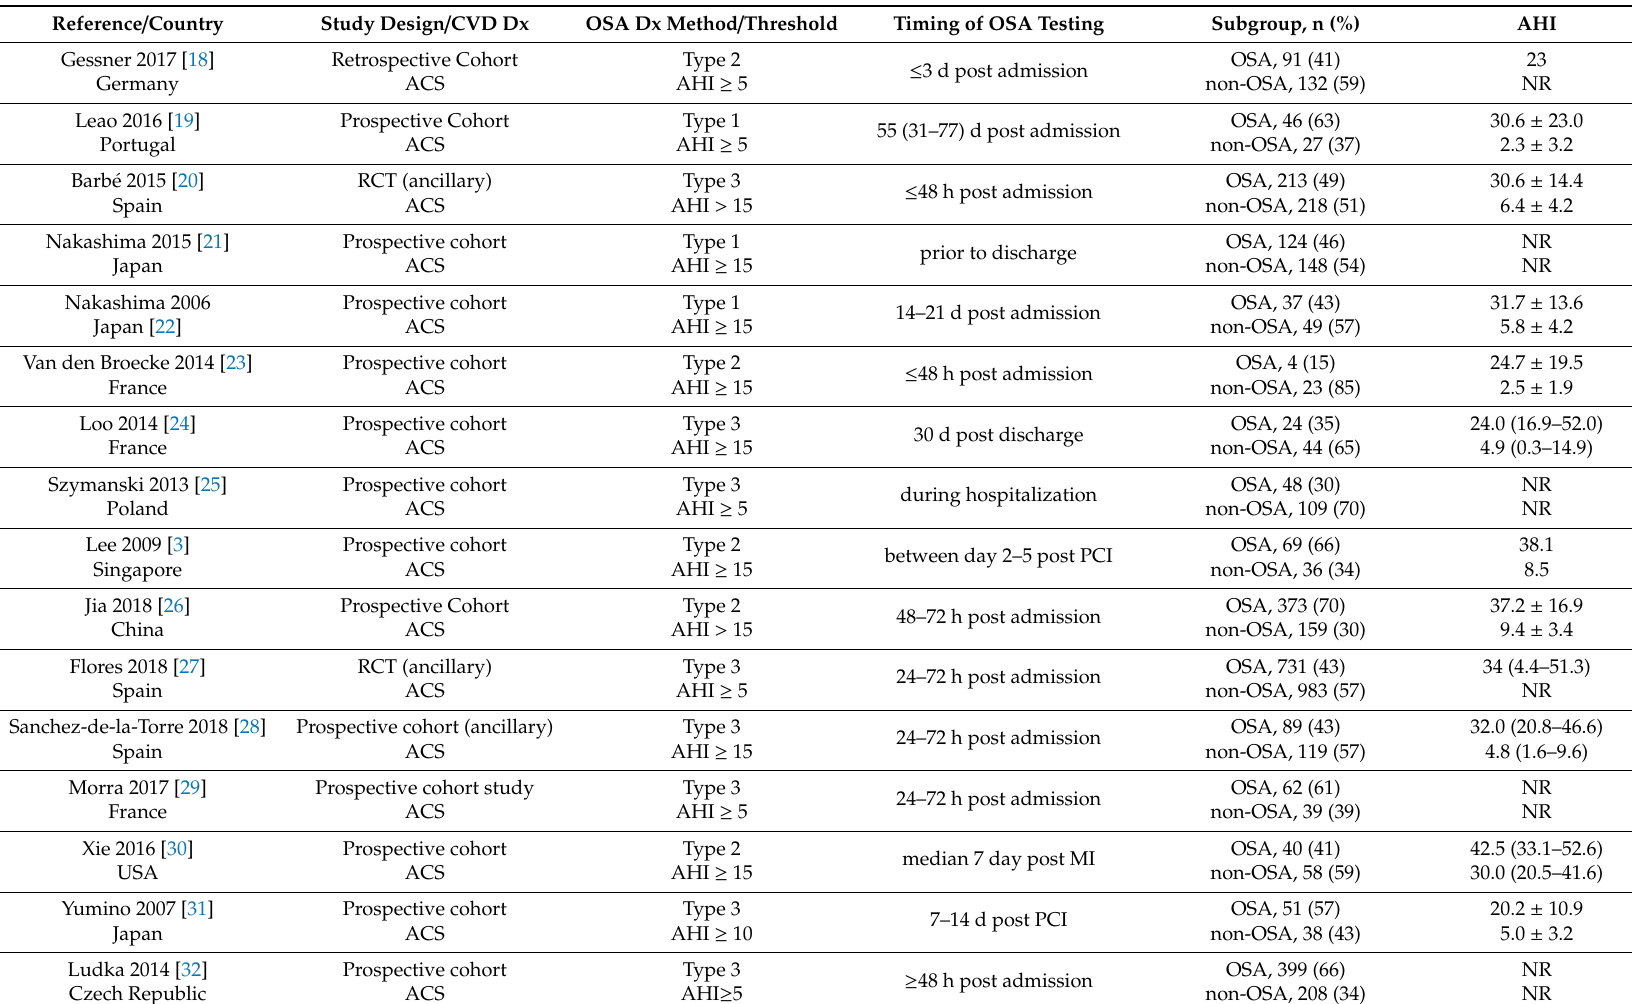
Table 1. Study and patient